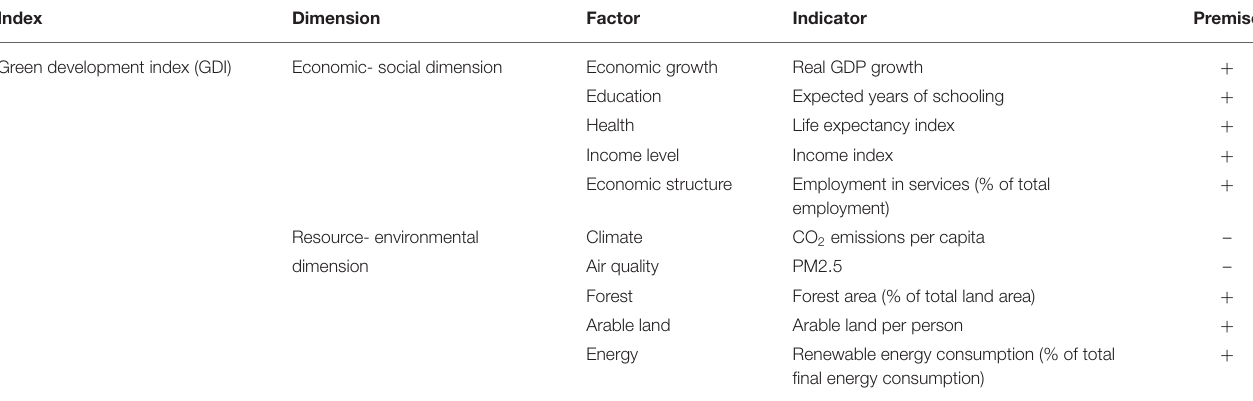
TABLE 1 | The structure of green development